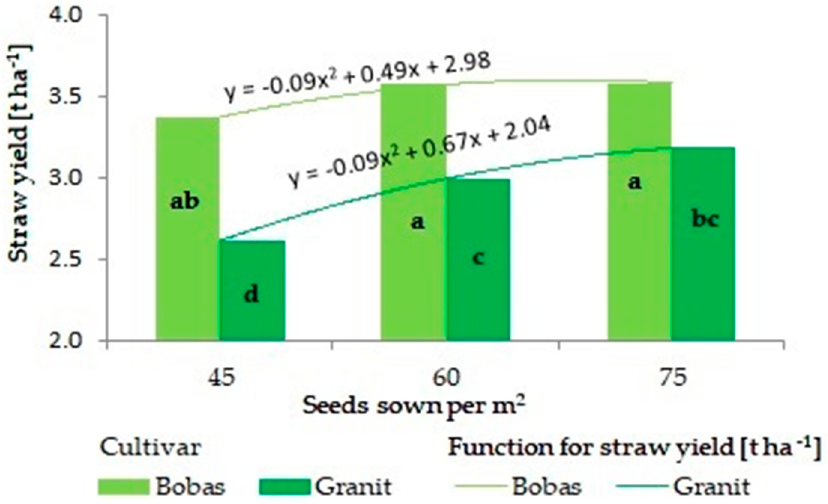
Figure 11. Straw yield in 2011(C × SDY). Different letters indicate significant differences between factors (Tukey’s multiple range test).